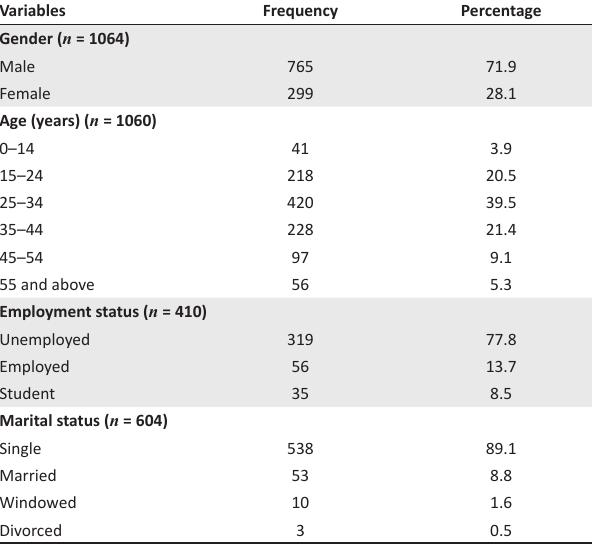
TABLE 1: Sociodemographic characteristics of the participants. Variables